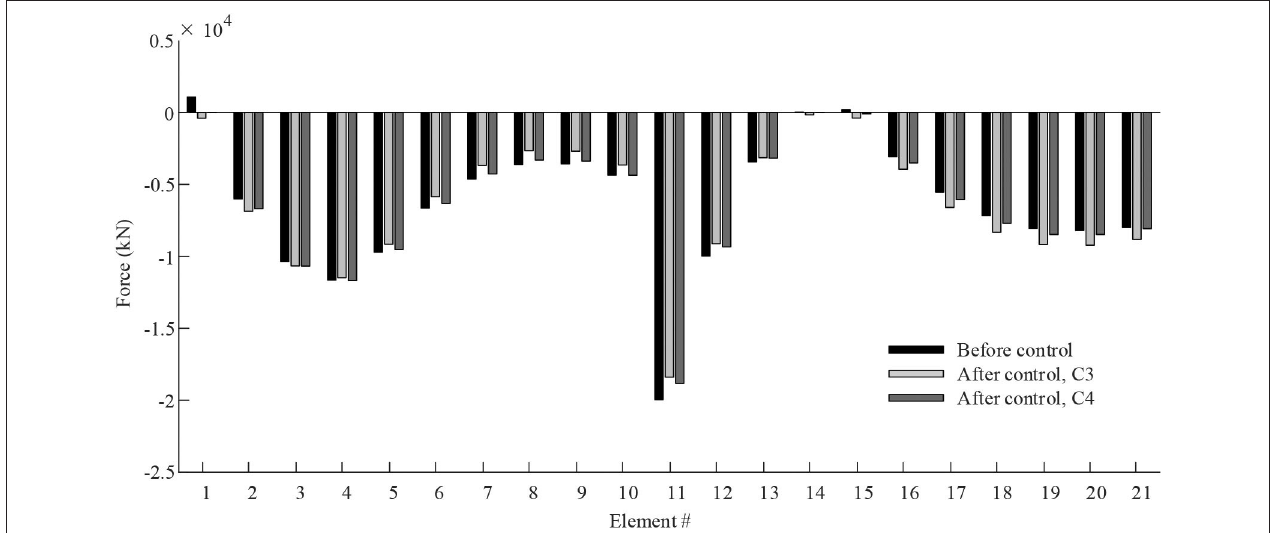
FIGURE 6 | Arch bridge: internal forces in the top and bottom chord elements for AC1b under LC2.